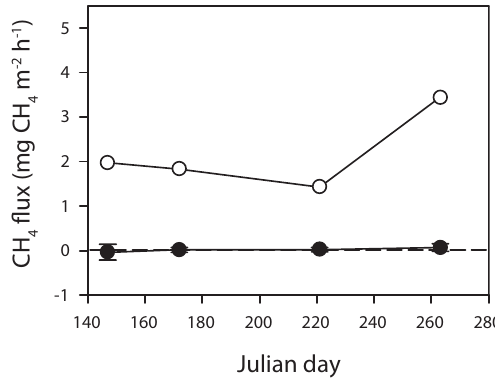
Figure 5. Methane (CH 4 ) emissions from the reference plots at Mørke with (- ◦ -) Juncus effusus ( n = 1) and without (- • -) Juncus effusus (mean ± standard error, n = 5) during the course of the field campaigns. The sampling positions were denoted E-PG in Petersen et al.